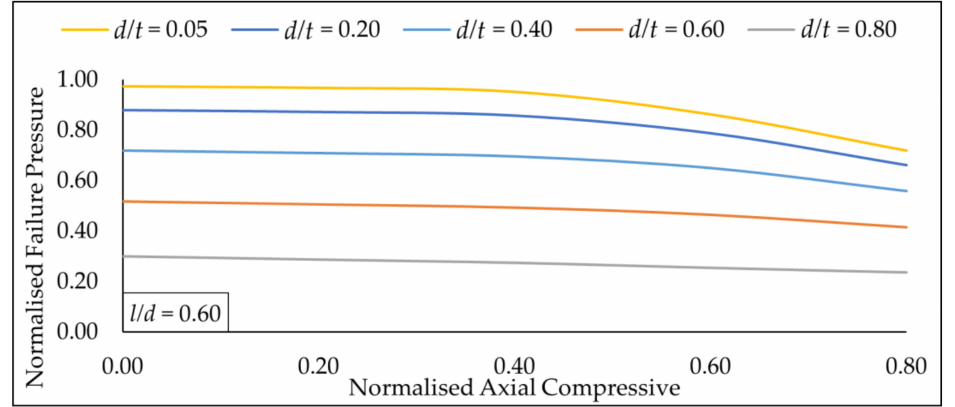
Figure 21. Normalized failure pressure predictions of the new assessment method against various normalized axial compressive stress for multiple normalised defect depths at a constant normalized defect length of